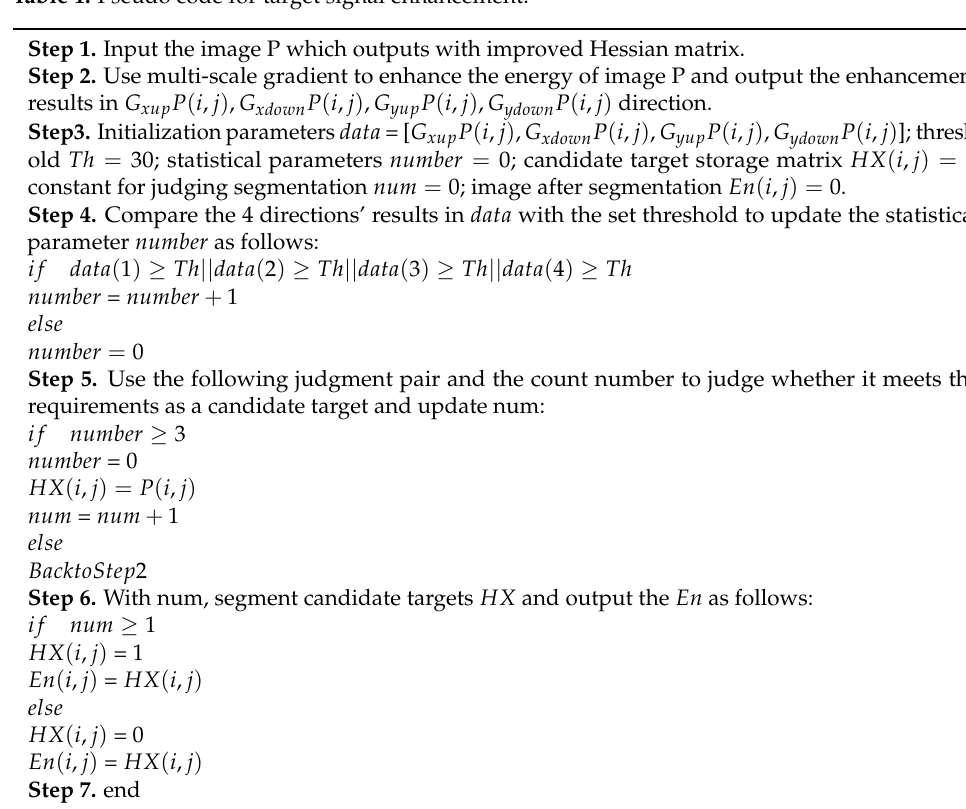
Figure 2. Flow chart of Hessian matrix background suppression model with local gradient significance. Table 1. Pseudo code for target signal